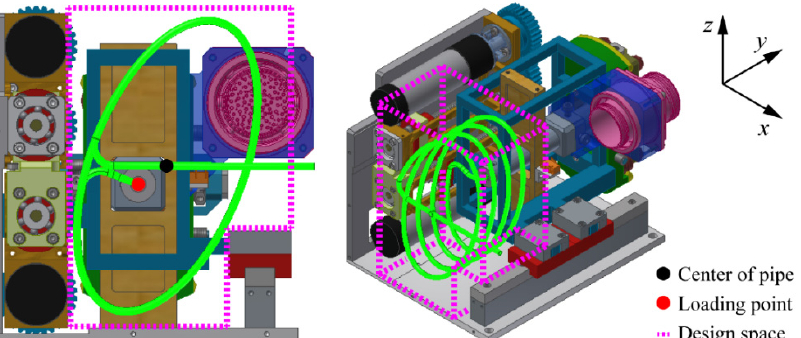
Figure 7. Configuration and design space of the elliptical-helical pipe with bias loading. The red point represents the loading point that connects the drogue and refueling pipe; the yellow point represents the center of the elliptical pipe fixed to the load-carrying plate; the pink dashed line indicates the design space for the refueling pipe, outside of which the envelope of pipe cannot extend.